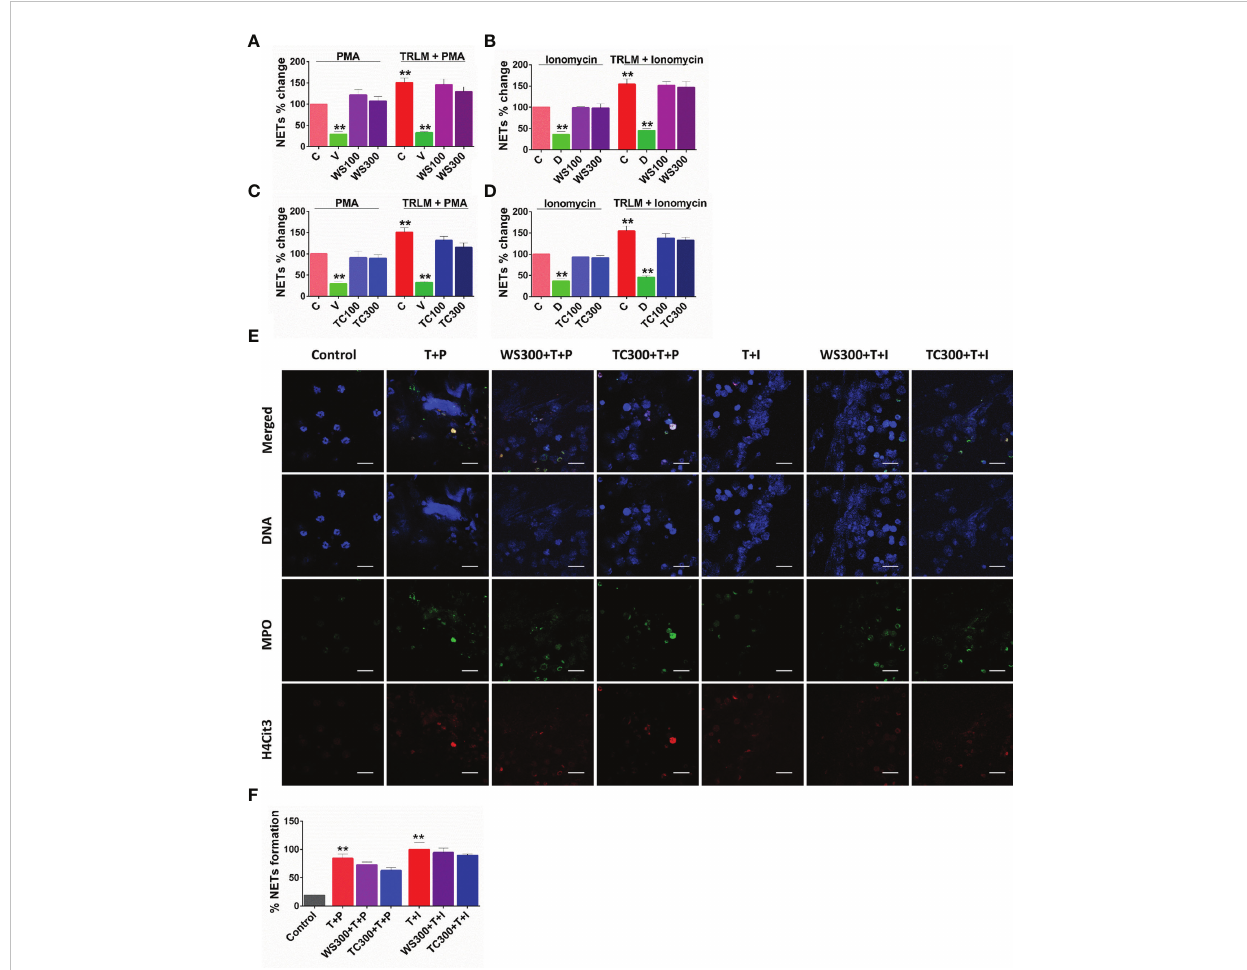
FIGURE 4 Effect of WS and TC on TRLM primed-PMA/ionomycin induced cytosolic ROS and mtROS production in human PMNs. PMNs pre-incubated at different concentrations of TC and WS were treated with TRLM (10 µg/ml) for 30 min and stimulated with sub-maximal concentration of PMA (12.5 nM) and ionomycin (2 µM) for 30 min. DCF-DA (10 µM) and MitoSOX (10 µM) were used for cytosolic ROS and mtROS detection, respectively using fl ow cytometry. All the data are represented as Mean ± SEM, n = min 3 per group, and statistical analysis consisted of one-way ANOVA followed